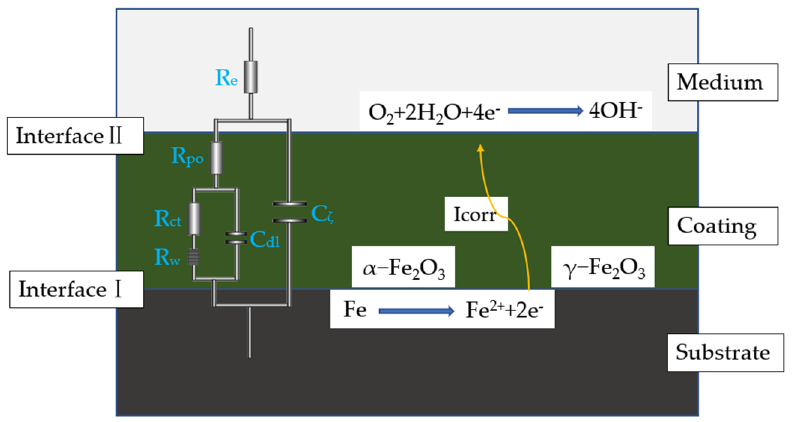
Figure 10. Separation of the anode and cathode reactions in the metal corrosion process with coatings (right)/equivalent circuit (left).